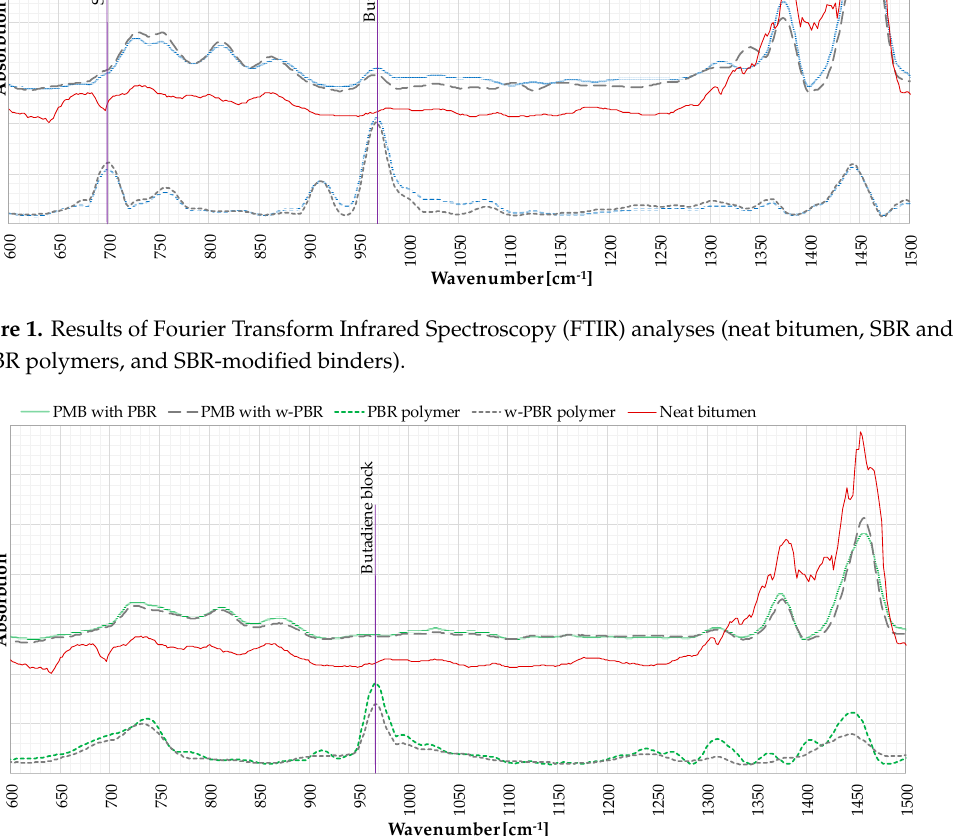
Figure 2. Results of FTIR analyses (neat bitumen, PBR and w-PBR polymers, and PBR-modified binders).